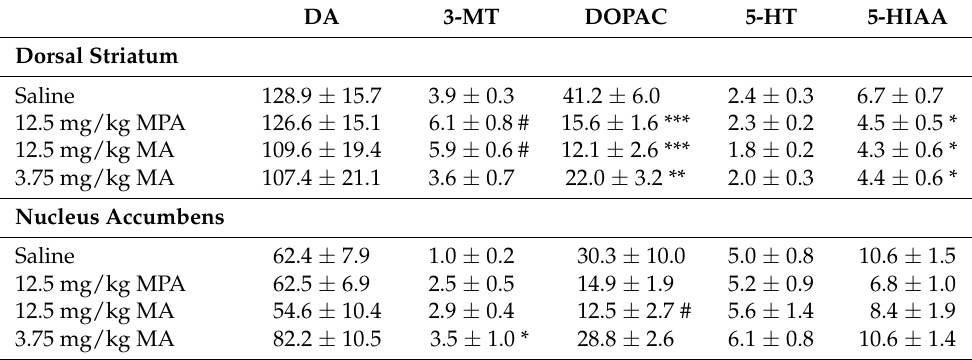
Table 2. Concentrations (nmol/g) of DA, the DA metabolites 3-MT and DOPAC, 5-HT and the